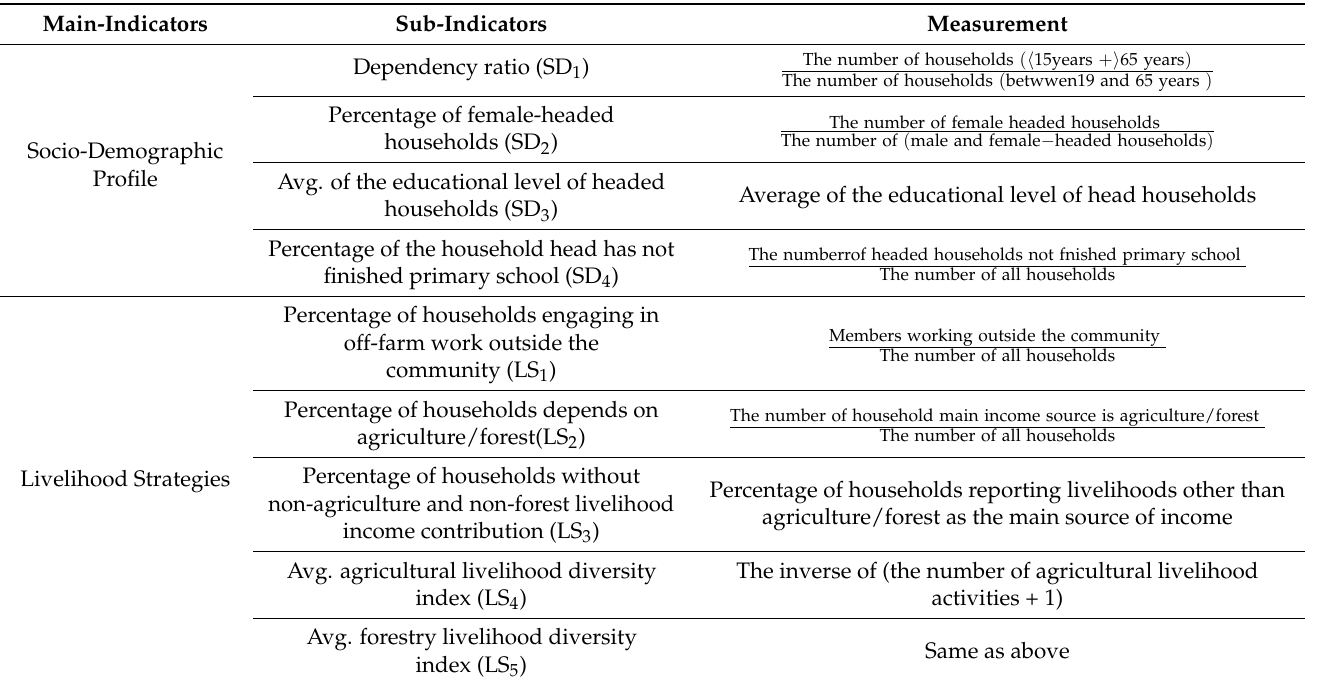
Figure 1. The vulnerable eco-distribution in China and the sites used in this study. Table 2. Main indicators and sub-indicators comprising the Household Livelihood Vulnerability Index (HLVI) developed for the